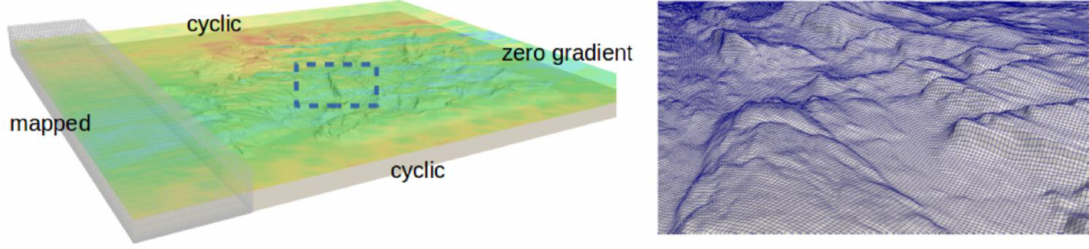
Figure 5. Right : illustration of the computational domain with the prolonged inlet. The boundary conditions used in the simulation are illustrated. The ridge of interest can be seen in the center of the domain. The color coding represent velocity magnitude; Left : close up of the structured grid at the